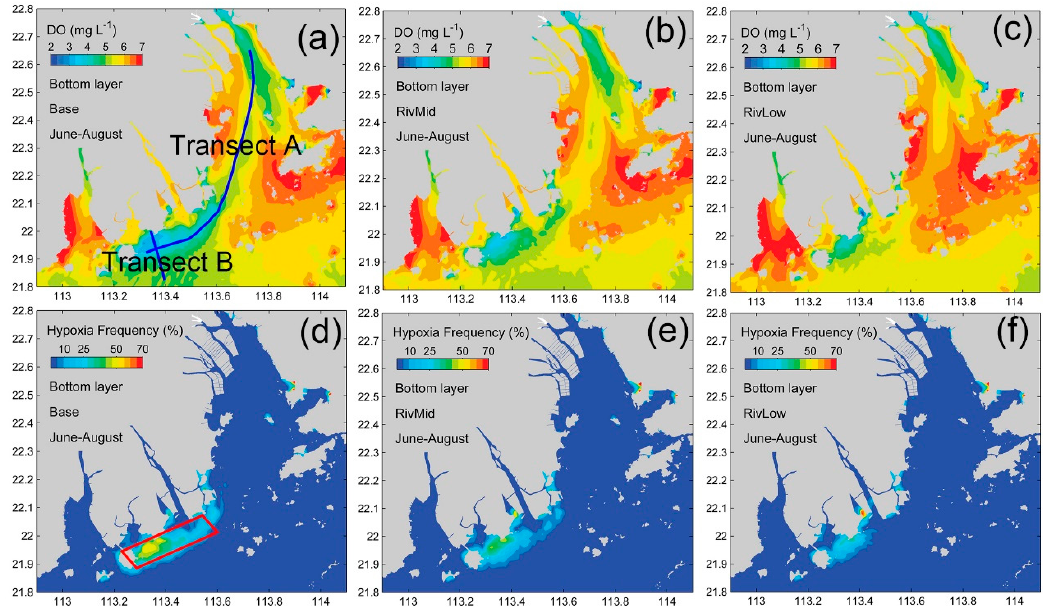
Figure 7. Spatial distribution of the simulated DO concentration ( a – c ) and the hypoxic frequency (HF) ( d – f ) in the bottom layer for the base ( a,d ), RivMid ( b , e ), and RivLow ( c , f ) cases. The red rectangle in ( d ) is the calculated area of the DO